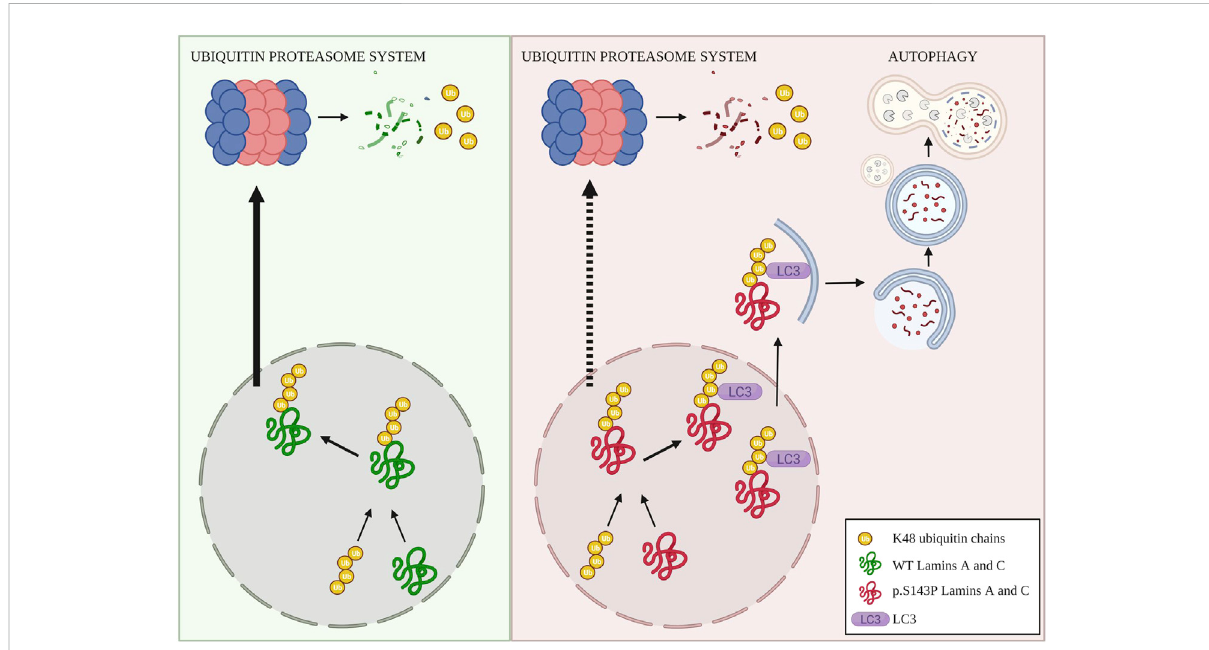
FIGURE 5 Illustrative picture of degradation of K48-ubiquitinated lamins A and C. In normal cells, wild-type lamins A and C are partially ubiquitinated with K48-linked chains that lead to UPS-mediated degradation of lamins A and C. In the patient cells, lamins A and C are increasingly K48-ubiquitinated, presumably due to increased turnover and production, as well as proteasomal dysfunction. This leads to saturation of UPS and an accumulation of K48-linked ubiquitin chains within the nucleus. Saturation and dysfunction of UPS further lead to compensatory degradation of K48-lamins A and C through autophagy, created with